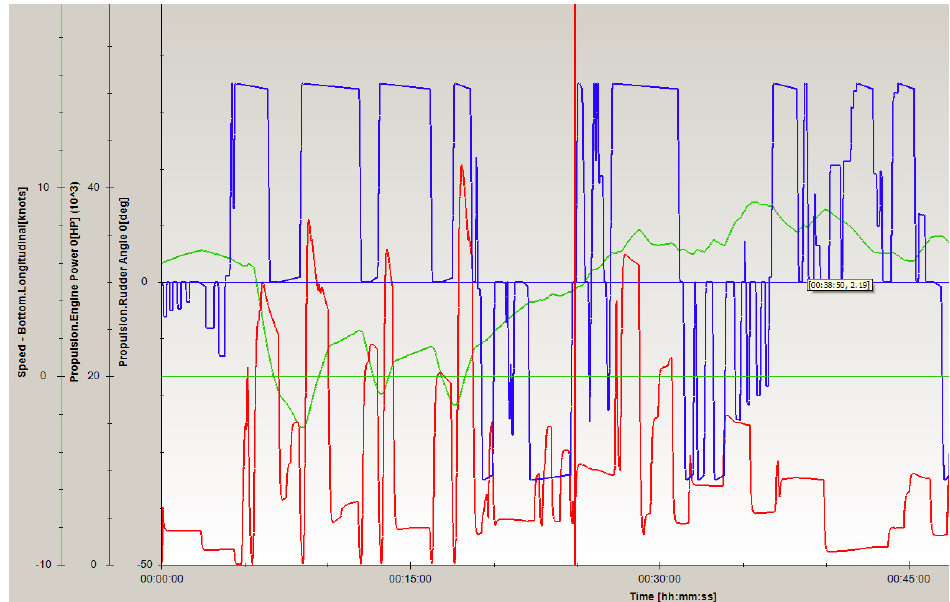
Figure 12. Sailing parameters of a PANAMAX-type container vessel crossing navigational channel near Korsakobben Island (entry to Stockholm archipelago from Baltic Sea): speed (green line); rudder angle (blue line); engine power (red line) (own elaboration based on [73]) (remark: -10; -50 in the figure read as –10; –50).